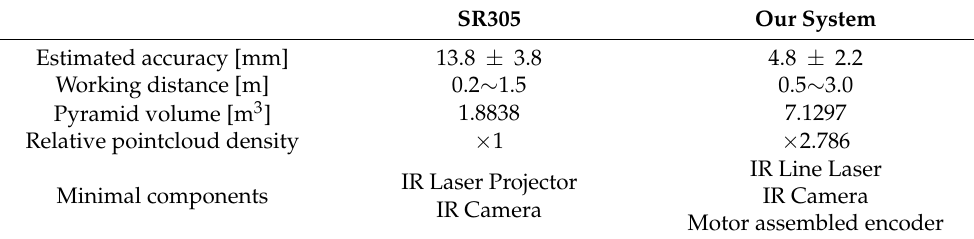
Figure 14. Distance errors from the checkerboard plane to every point. Table 1. Comparison between our system and the commercial sensor